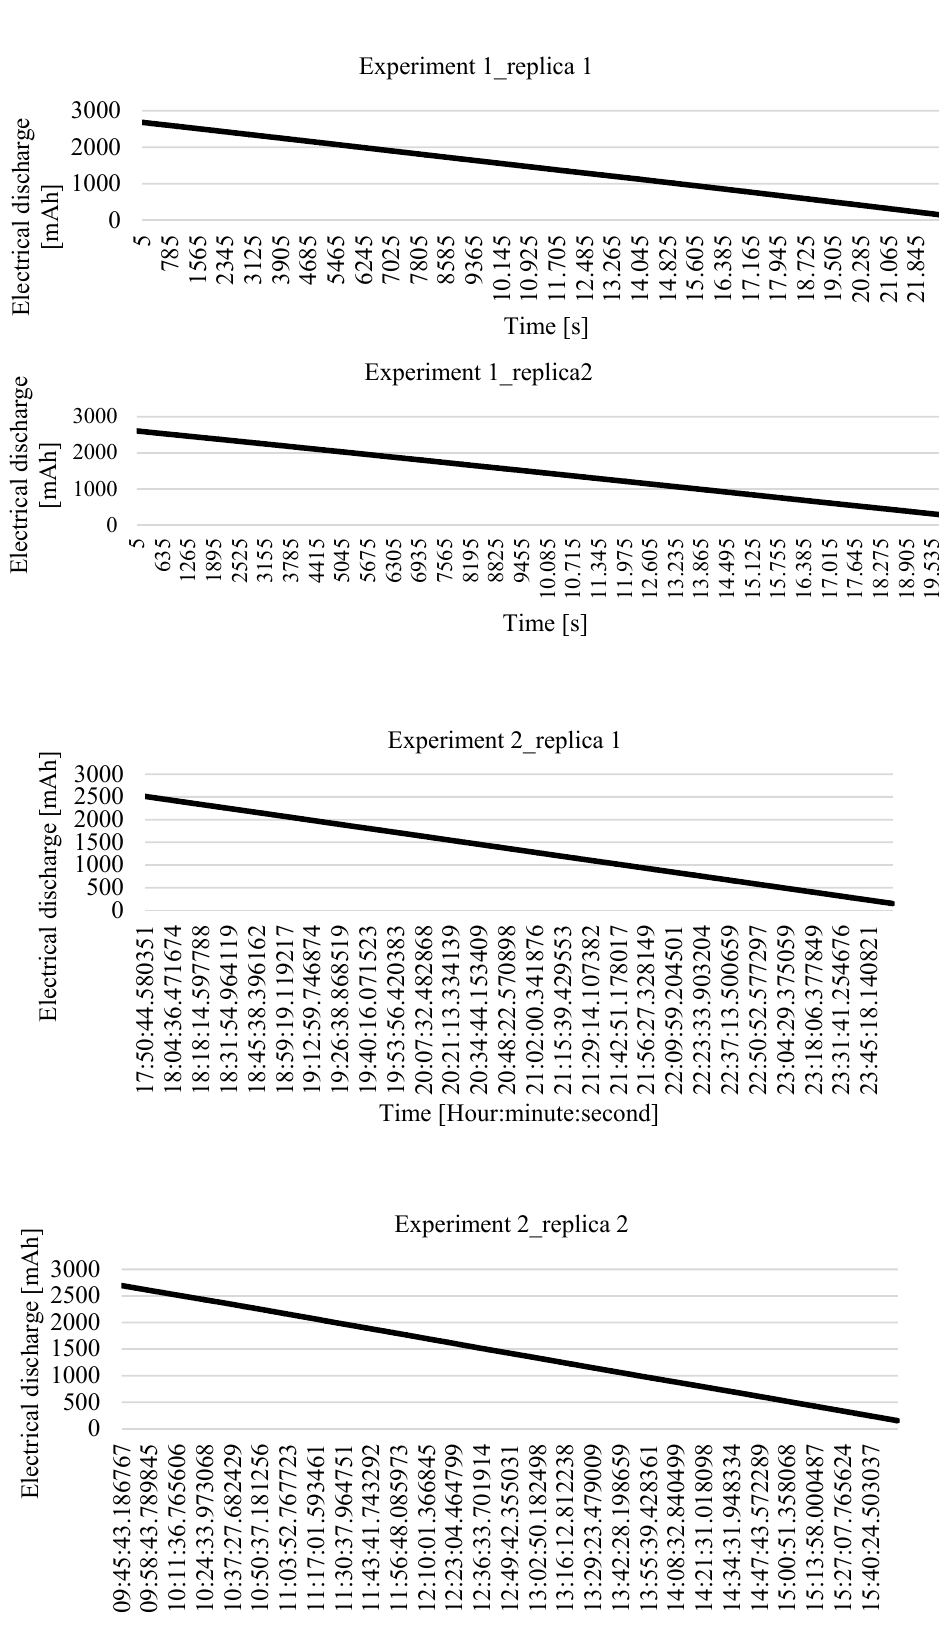
Figure 8. Behavior of electrical discharge variable in the robot’s battery during its operation in experiment 1 and 2.